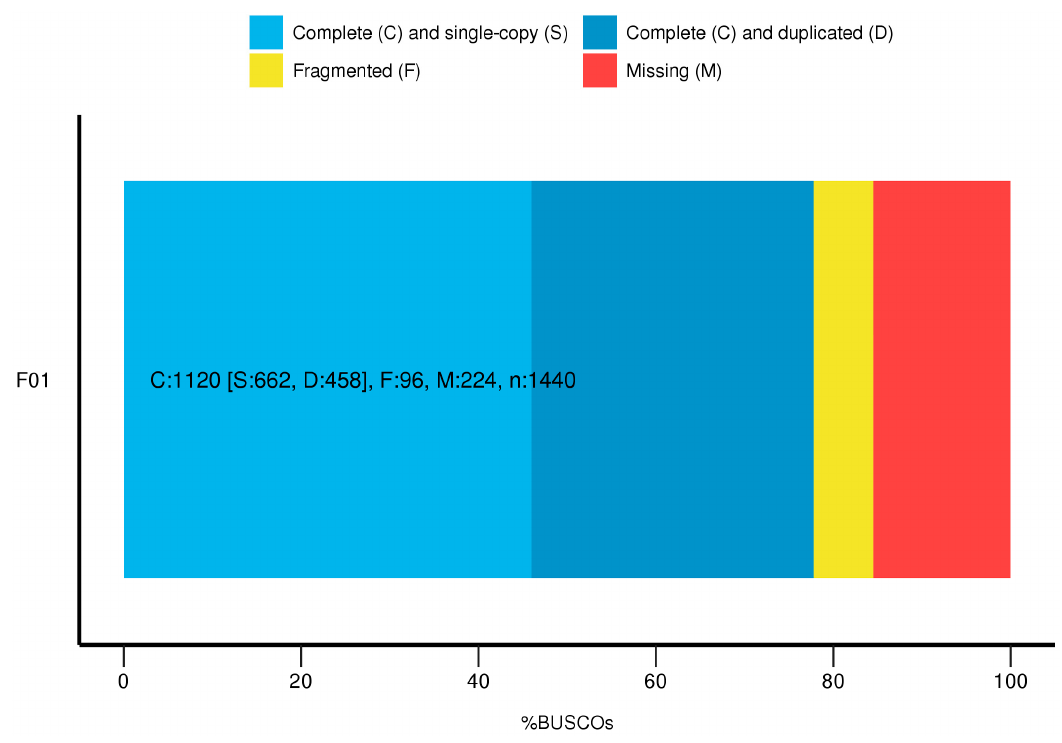
Figure 3. Result of the BUSCO assessment.